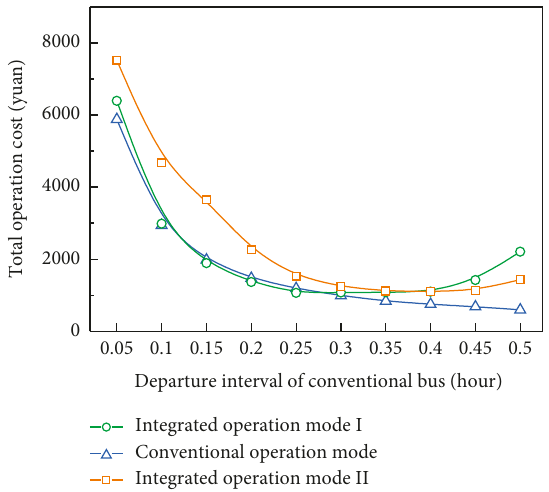
Figure 8: The total operating costs of different modes (the number of replaced stations is